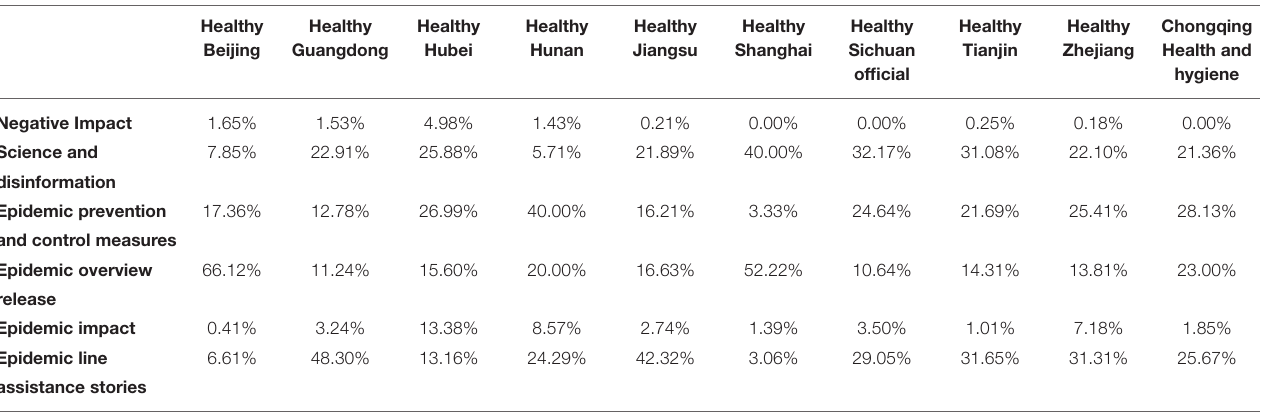
TABLE 5 | Percentage of each type of tweet in each public number.